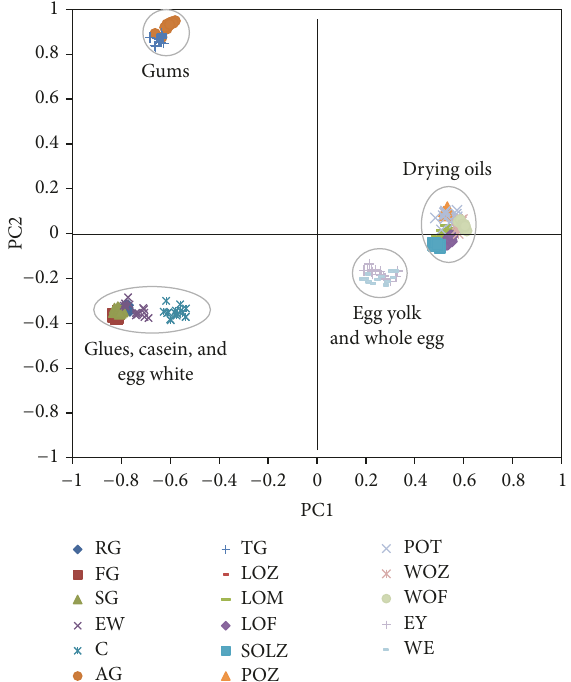
Figure 5: PCA applied to combined FT-NIR and Raman first derivative spectra, taking into account all neat binding media: score plot of PC1-PC2.